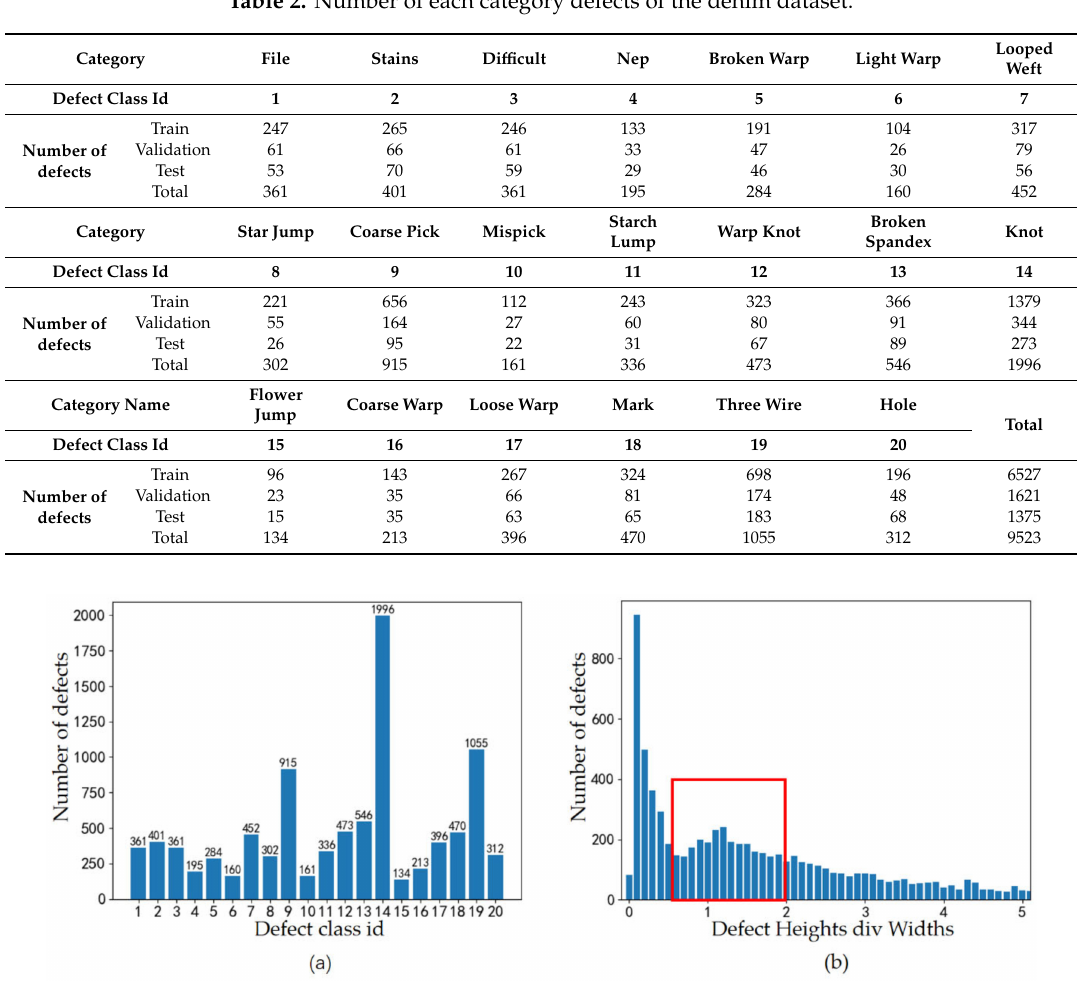
Figure 6. The distribution of defects. ( a ) number of defects classes ( b ) defects aspect